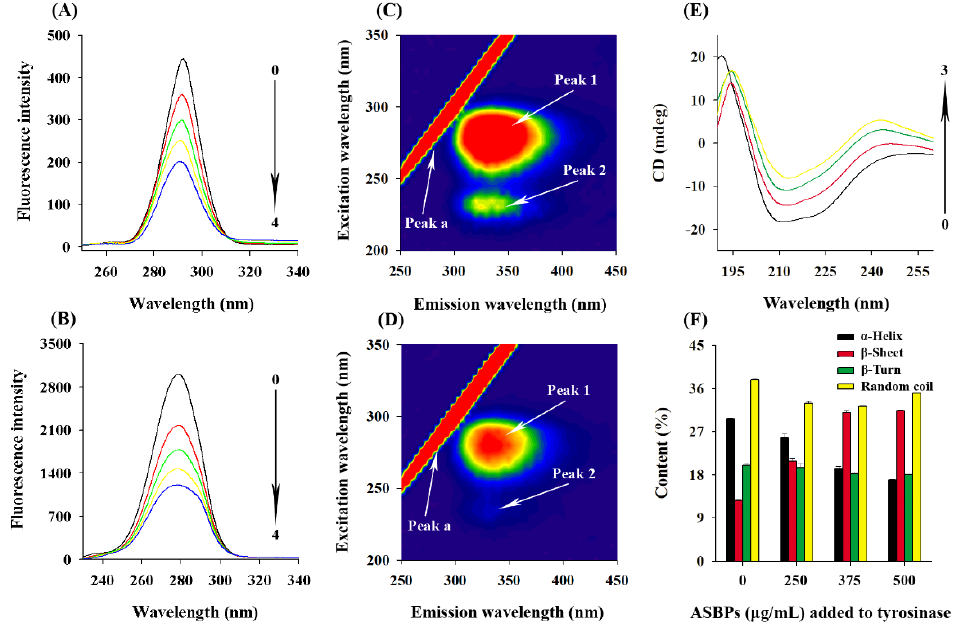
Figure 8. Synchronous fluorescence spectra of tyrosinase at different concentrations of ASBPs: ( A ) Δλ = 15 nm and ( B ) Δλ = 60 nm. Curves 0 – 4 represent ASBPs concentrations of 0, 10, 20, 30 and 40 µg/mL, respectively; Three-dimensional fluorescence spectra of tyrosinase without ( C ) and with ( D ) ASBPs; ( E ) Far-UV CD spectra of tyrosinase at different concentrations of ASBPs. Curves 0 – 3 repre- sent ASBPs concentrations of 0, 250, 375 and 500 µg/mL, respectively; ( F ) Secondary structure changes of tyrosinase at different concentrations of ASBPs.